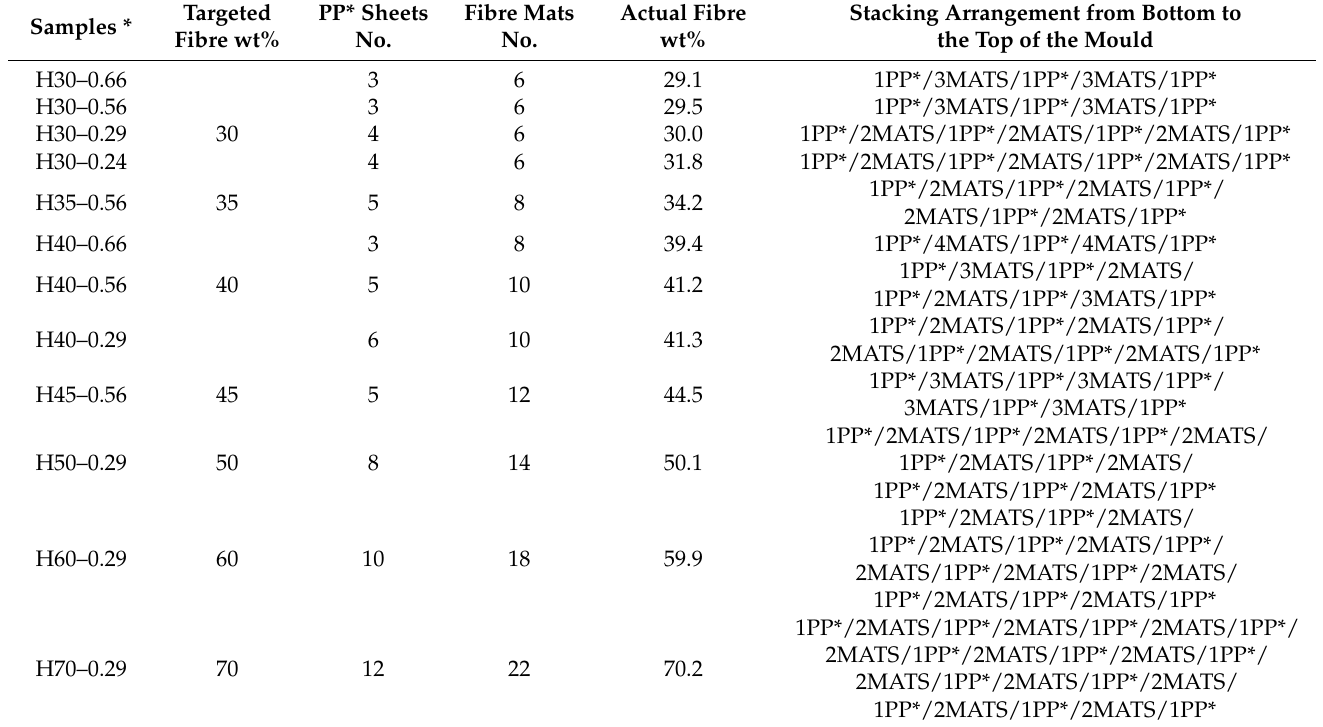
Table 1. Abbreviations and stacking arrangements of polymer sheets (PP/MAPP) and hemp fibre mats in the